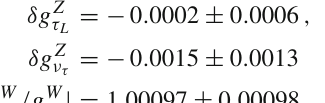
(cid:13) C i O i i